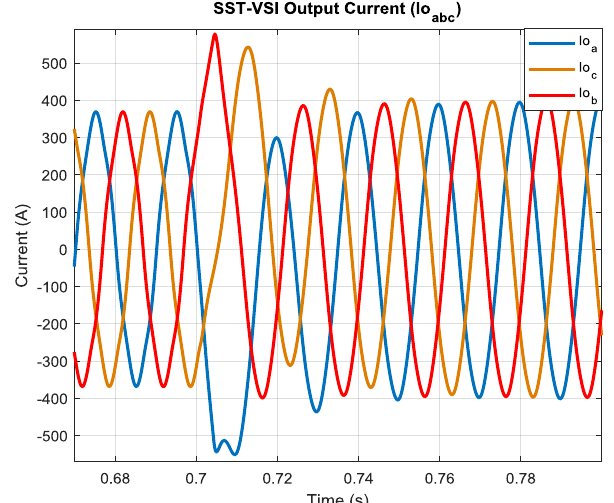
Figure 26. SST output current to the load. The figure is displaying the shift in phase of the